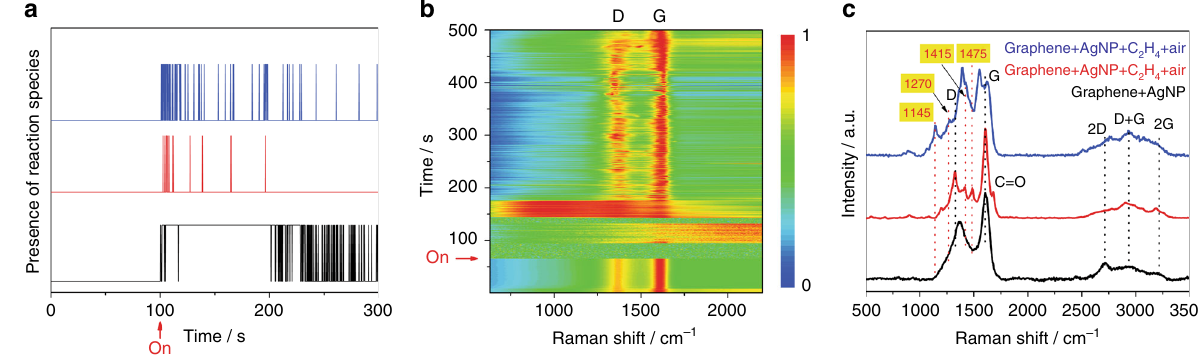
Fig. 2 Graphenic carbon formed in situ catalyzes C 2 H 4 epoxidation. a Digital reaction trajectory (presence of a reaction species vs. time) for a representative single Ag NP emitter under photocatalytic C 2 H 4 oxidation conditions corresponding to the data in Fig. 1e. The SERS monitoring was carried out under the fl ow of C 2 H 4 in air, which serves as the source of oxygen. The trajectories, shown stacked, demonstrate the correlation between the presence of graphenic carbon and the formation and detection of C 2 H 4 oxidation reaction species, as also shown by additional examples in Supplementary Fig. 5. b Time series of SERS spectra, shown by a waterfall plot, for a single graphene-covered Ag NP emitter. Continuous SERS spectra were taken at a rate of 0.2 s per frame and are shown normalized. The instant when C 2 H 4 fl ow was introduced is labeled as on. c Selected time slices from in situ SERS study of the single graphene-covered Ag NP emitter in ( b ). The SERS spectrum before start of C 2 H 4 fl ow (black curve, t = 40 s slice) shows D, G, 2D, and D + G modes of graphene. The SERS spectra under C 2 H 4 epoxidation conditions (red curve, t = 372 s and blue curve, t = 181.2 s) show formation of EO. Spectra are shown normalized and stacked with the key vibrational modes labeled with the peak wavenumbers indicated in cm −